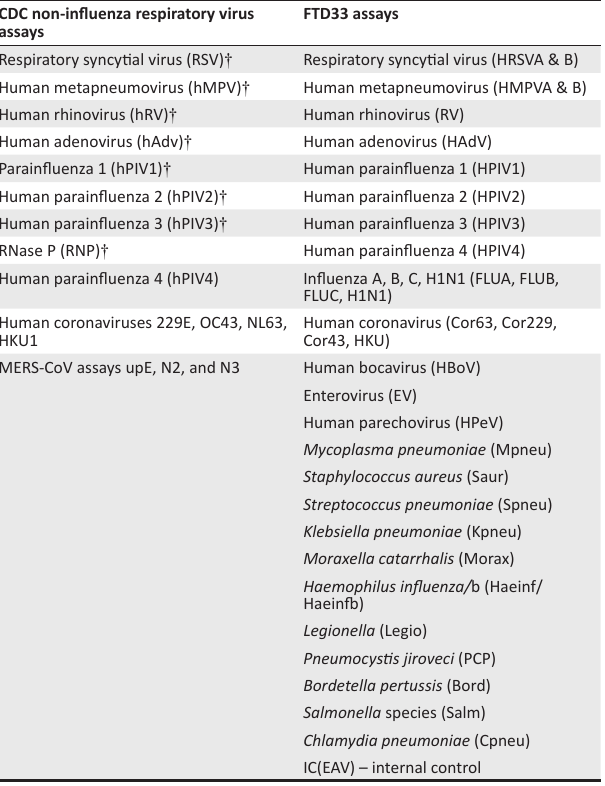
TABLE 2: Human respiratory pathogens targeted by Centers for Disease Control and Prevention assays and fast-track diagnostics respiratory pathogens panel. CDC non-influenza respiratory virus